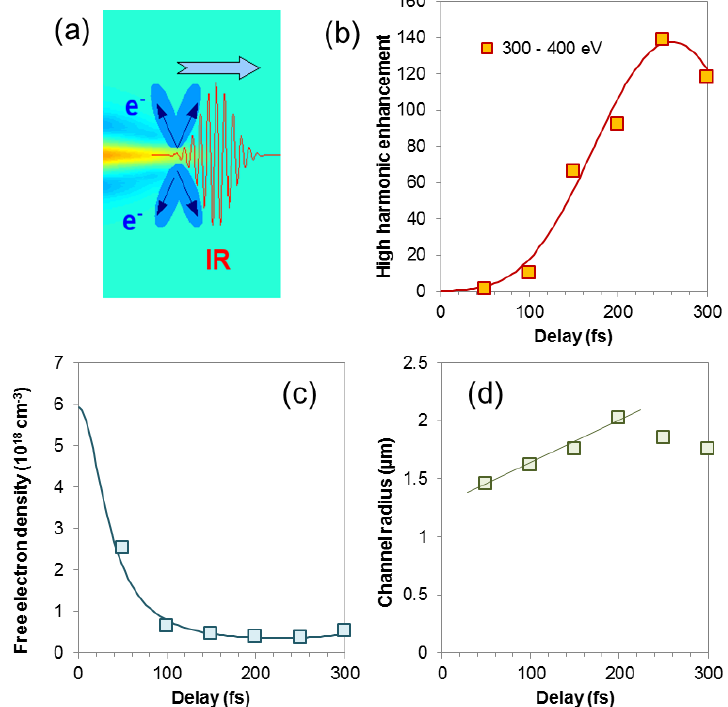
Figure 6. ( a ) An electron-free ion channel is formed by an intense ionizing laser pulse. ( b ) The delayed second pulse efficiently generates HHG from the ions, and the